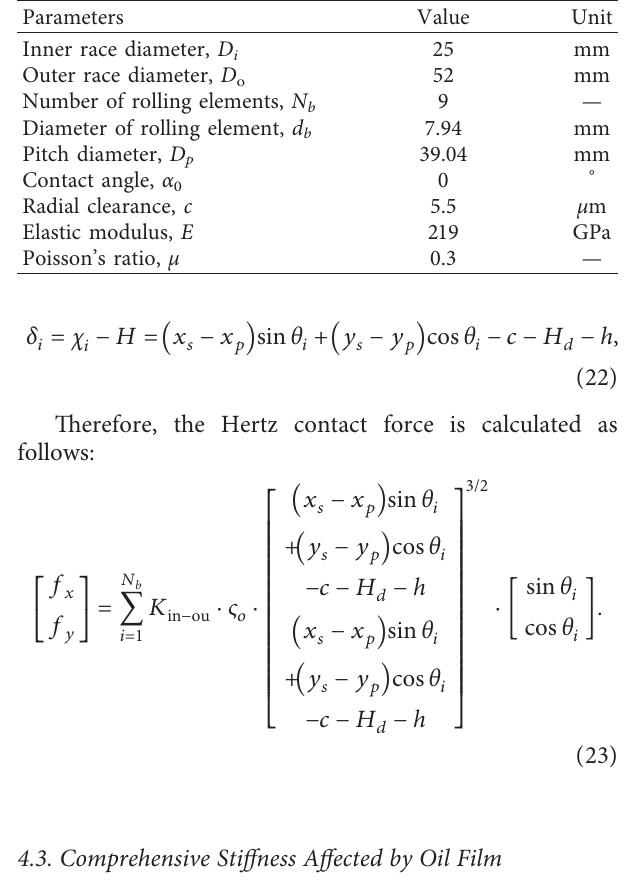
Table 1: Specific parameters of deep groove ball bearing SKF